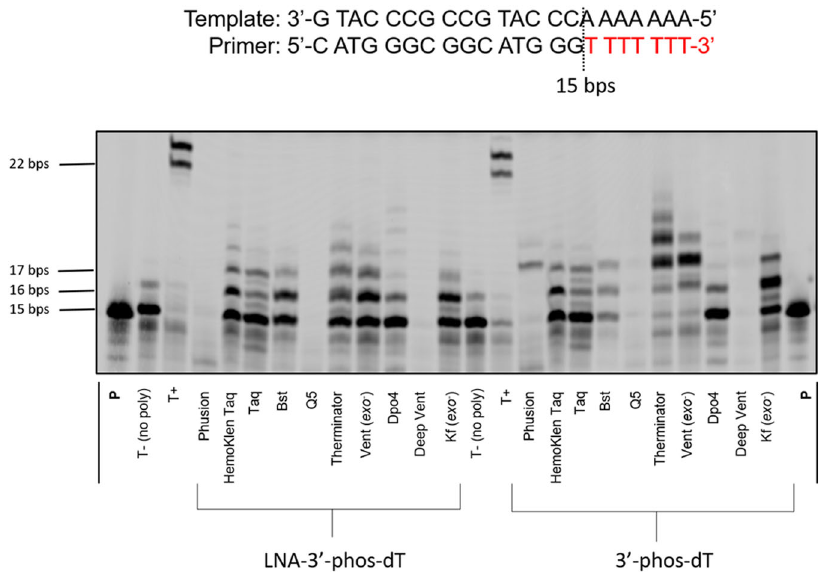
Fig. 4 Primer extension reactions with modi fi ed nucleotides 5 and 10 on a template containing a terminal stretch of dA nucleotides. Gel image (PAGE 20%) shows the results of PEX reactions with 3 ′ -phos-dTTP 5 and 3 ′ -phos-LNA-TTP 10 with the P1 / T2 primer/template system and various DNA polymerases. Modi fi ed triphosphates were at a fi nal concentration of 200 µ M. The following quantities of polymerases and reaction conditions were used: Phusion (2 U), Hemo Klen Taq (8 reactions), Taq (5 U), Bst (8 U), Q5 (2 U), Therminator (2 U), Vent ( exo − ) (2 U): 60 °C, 1 h; Dpo4 (2 U), Deep Vent (2